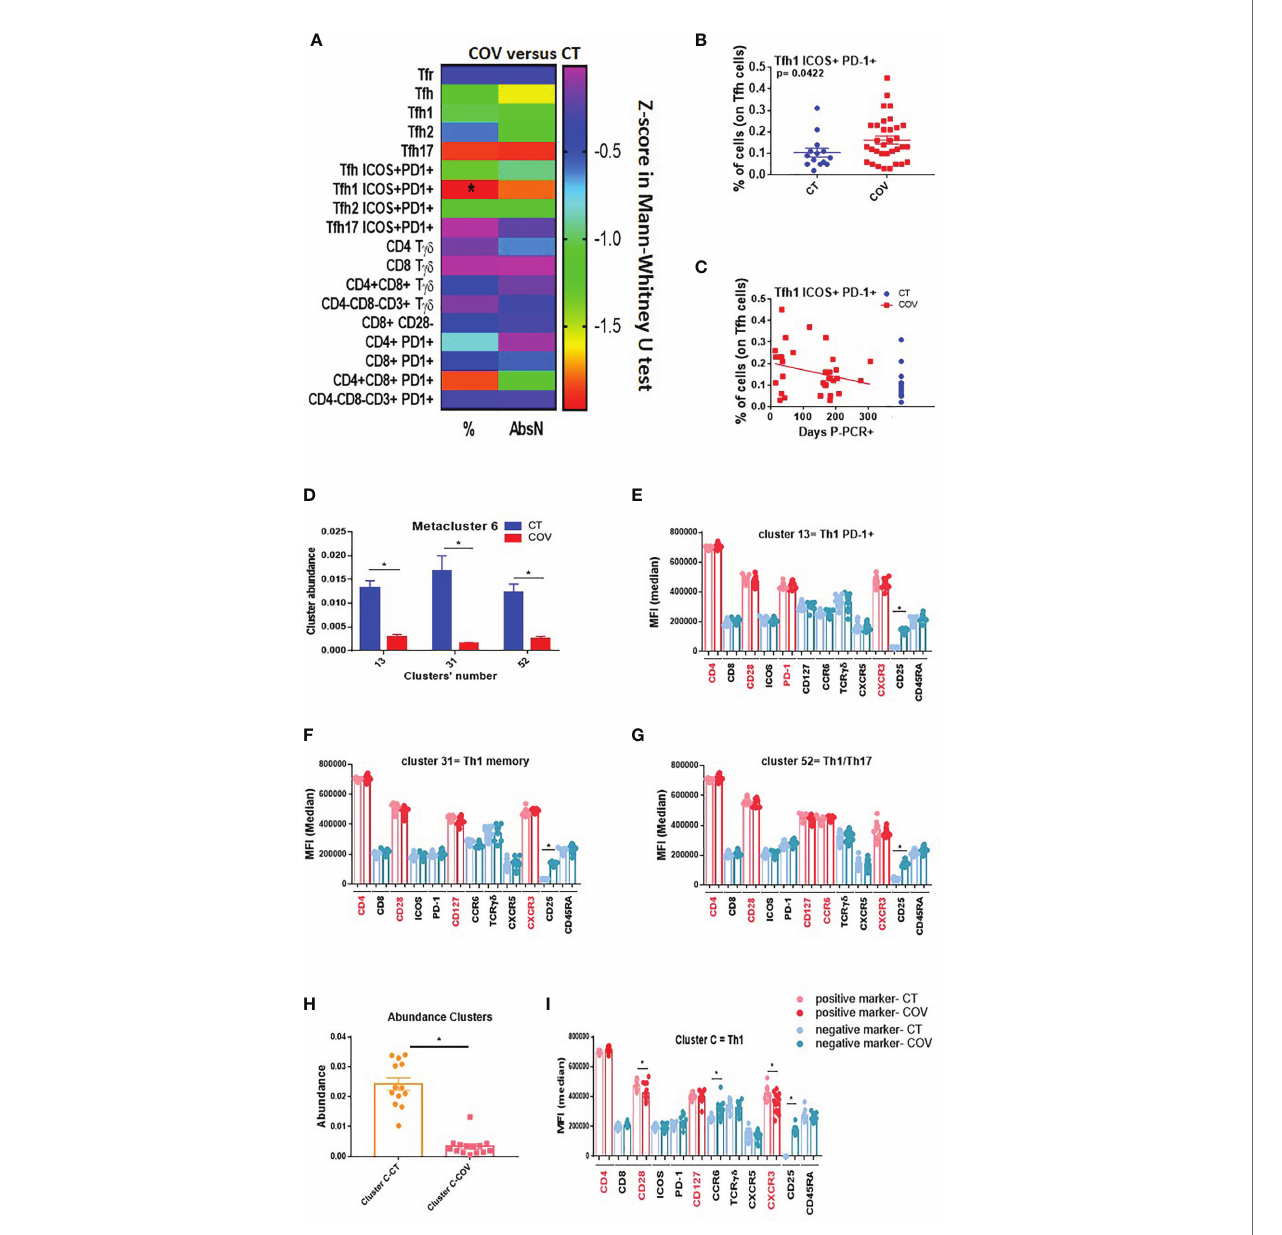
FIGURE 3 | Manual gating and high-dimensional fl ow cytometry unsupervised analysis in Tfh – T gd cells panel. (A) Heat map of the pairwise comparison between recovered COVID-19 (COV) and healthy control (CT) individuals of cellular subsets obtained by classical manual fl ow cytometry gating. Analysis was performed with the Mann – Whitney U test. The colour scale represents Z-score on the right Y-axis. Immune population names are represented on the left Y-axis. The left column represents the z-score from the pairwise comparison for the cellular population ’ s percentage (%), and the right column represents the z-score from the pairwise comparison for the absolute numbers (cells/uL, AbsN). p-value was adjusted by the Benjamini – Hochberg adjustment method for multiple testing, * p < 0.05. (B) Frequency of Tfh1 ICOS+ PD-1+ in CT and COV individuals. Pairwise comparisons were performed using a Man – Whitney U-test with Benjamini – Hochberg adjustment for multiple testing. Mean ± SEM. (C) Correlation between days P-PCR+ and frequency of Tfh ICOS+ PD-1+. Spearman ’ s rank-order correlation test with Benjamini – Hochberg adjustment for multiple testing. (D) The abundance of the three metaclusters was obtained through FlowSOM analysis. One-way ANOVA with Benjamini – Hochberg adjustment for multiple testing. Median ± SEM. (E) Medians of fl uorescence (MFI) of clusters 13, 31 (F) , and 52 (G) were obtained through FlowSOM analysis. One-way ANOVA with Benjamini – Hochberg adjustment for multiple testing. Median ± SEM. (H) The abundance of the cluster was signi fi cantly different between CT and COV individuals, as obtained through CITRUS analysis. One-way ANOVA with Benjamini – Hochberg adjustment for multiple testing. Median ± SEM. (I) MFI of cluster C was obtained through CITRUS analysis. One-way ANOVA with Benjamini – Hochberg adjustment for multiple testing. Median ± SEM. * p <